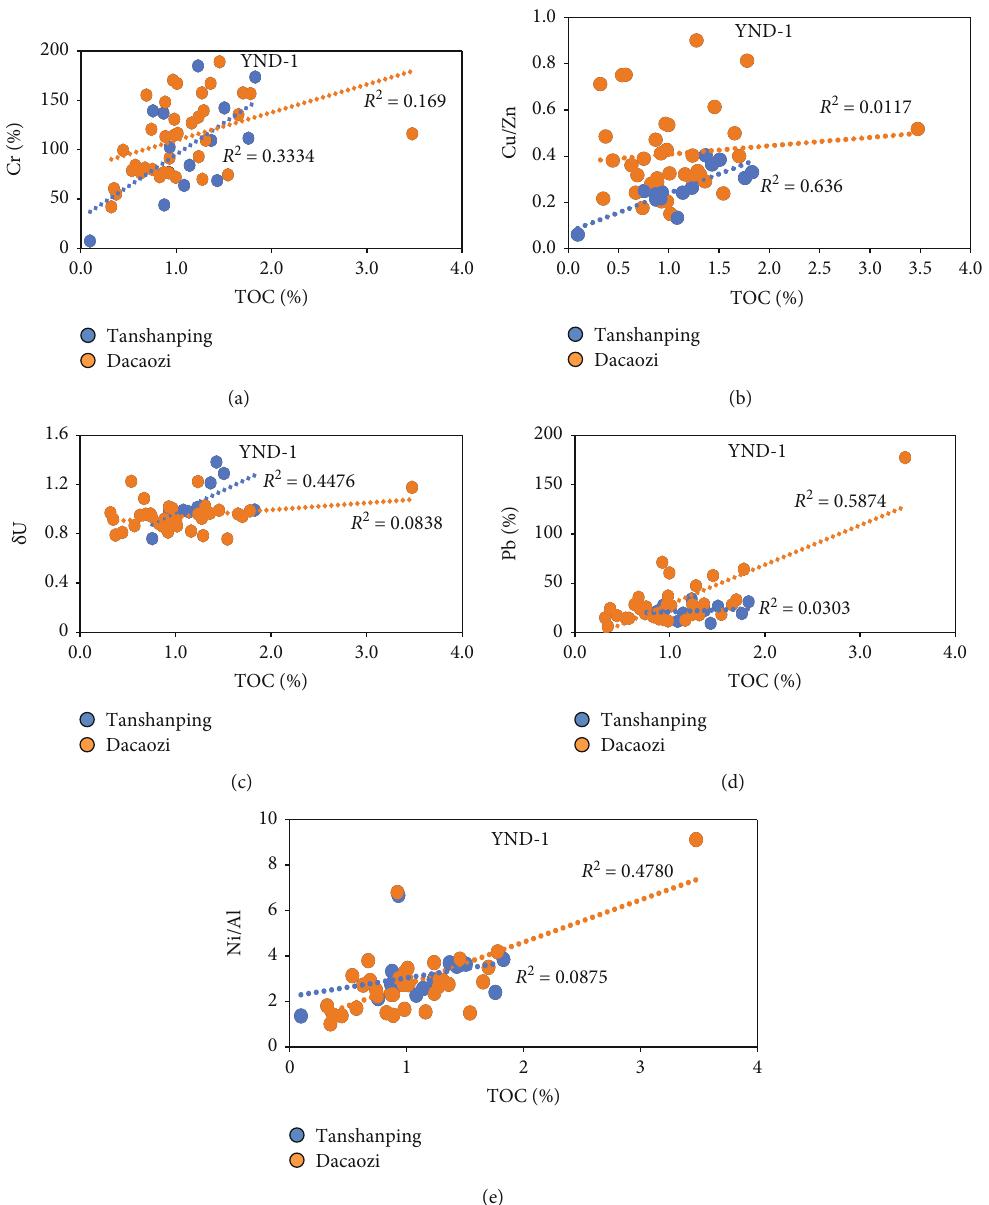
Figure 8: Crossplots of redox indexes (Cr, Cu/Zn, and δ U) versus TOC content and paleoproductivity indexes (Pb and Ni/Al) versus TOC content of the Tanshanping and Dacaozi